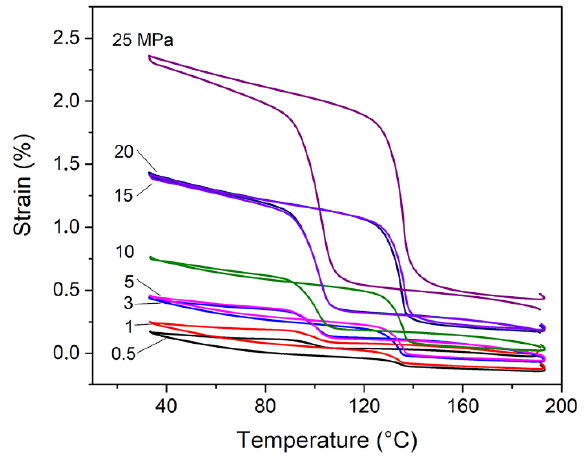
Figure 6. Strain recovery measurements under constant loads vs. Temperature of the sample B. Curves are labelled with constant loads values in MPa.